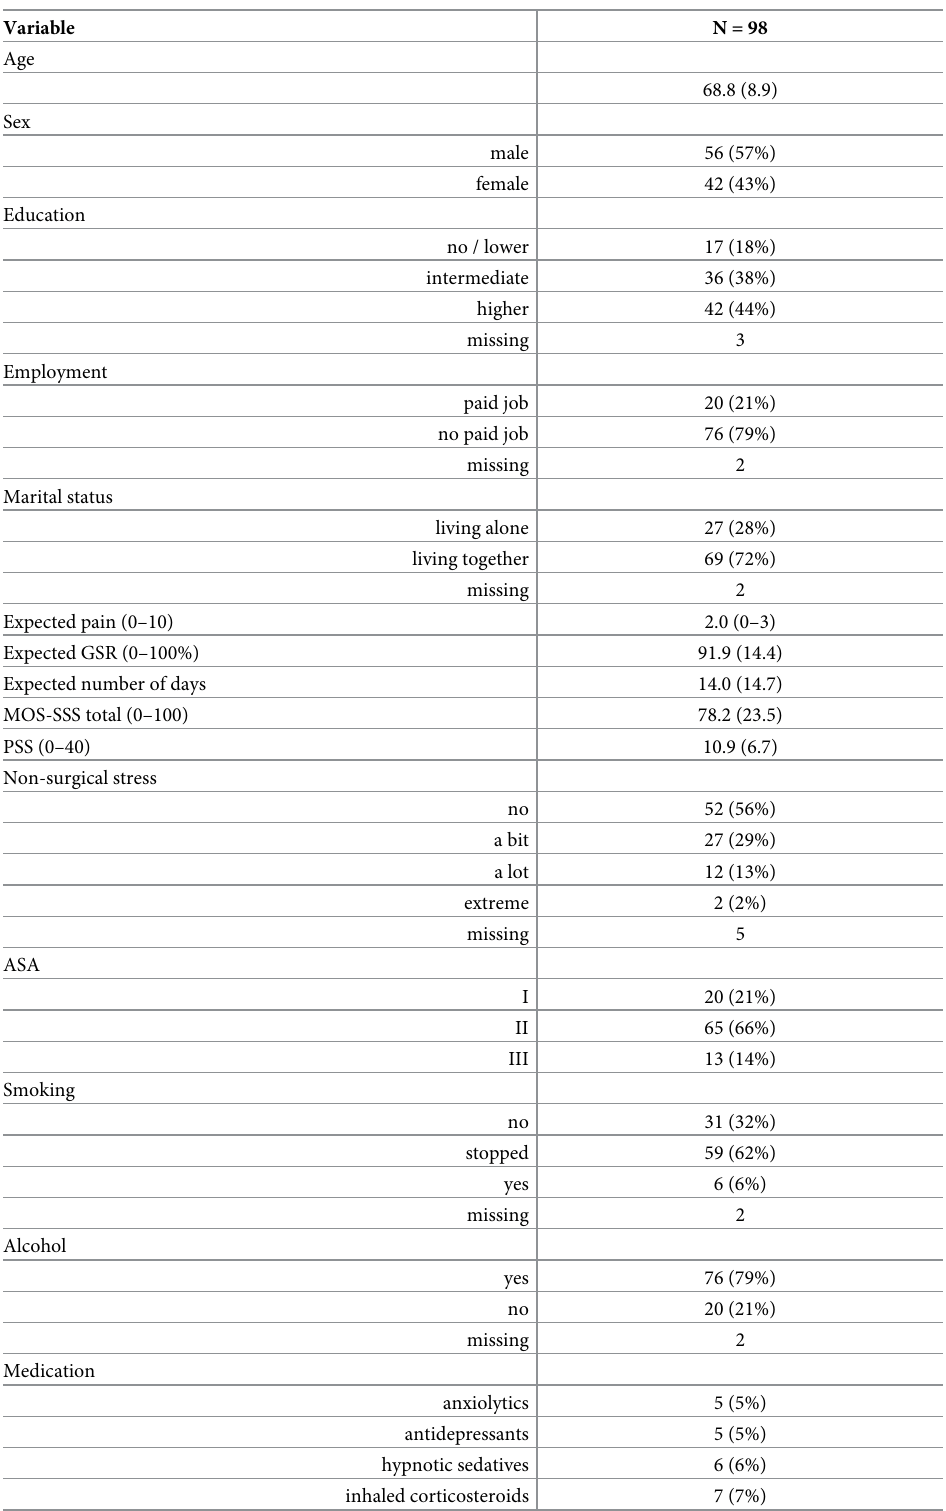
Table 1. Baseline